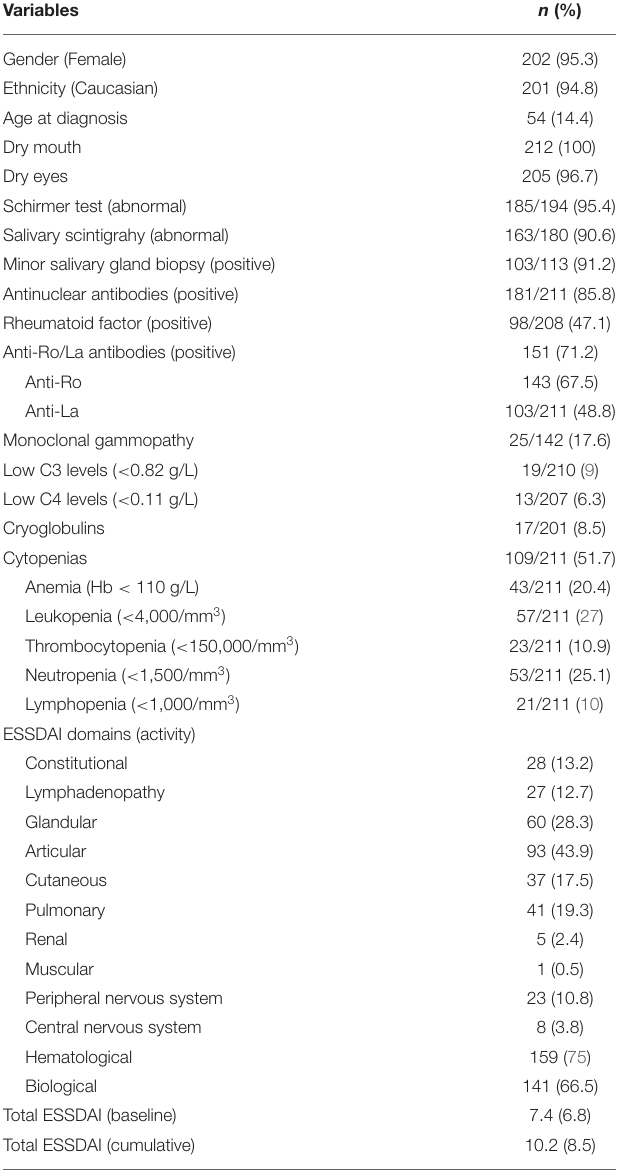
TABLE 1 | General characteristics of the primary Sjögren’s syndrome (pSS)